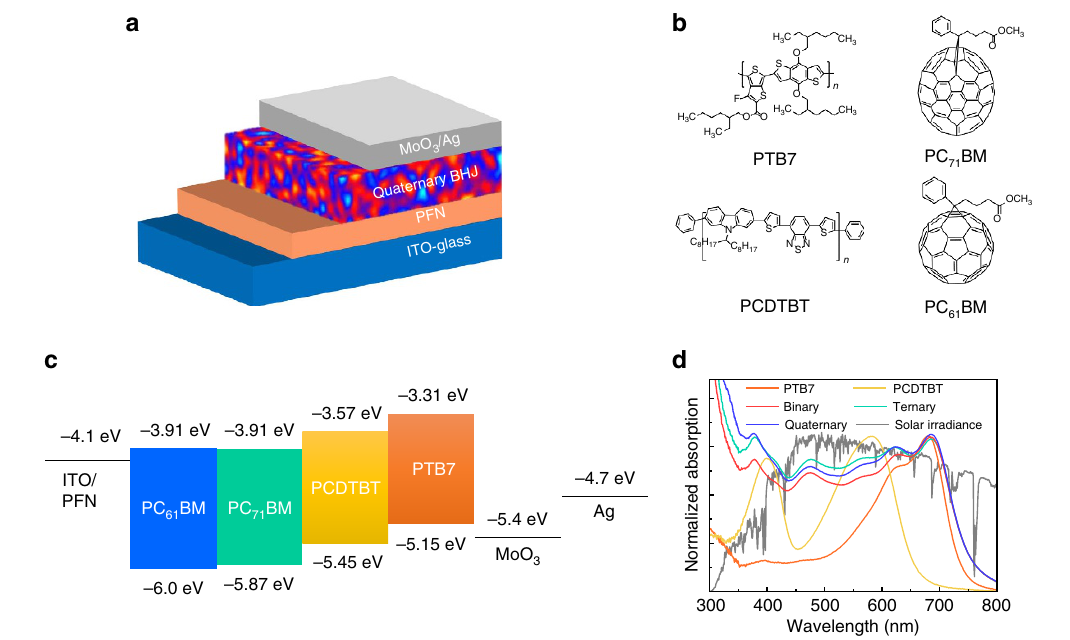
Figure 1 | Device structure and optical properties of materials. ( a ) Schematic diagram of the OPV, ( b ) molecular structure of the D and A materials and ( c ) energy band diagram of the q-OPV. The energy levels of PTB7, PCDTBT, PC 71 BM and PC 61 BM were obtained from refs 20–22. ( d ) Ultraviolet–visible–NIR absorption spectra of films of pure PTB7, pure PCDTBT, binary PTB7:PC 71 BM (1.0:1.5) blend, ternary PTB7:PCDTBT:PC 71 BM (0.9:0.1:1.5) blend and quaternary PTB7:PCDTBT:PC 71 BM:PC 61 BM (0.9:0.1:1.2:0.3)